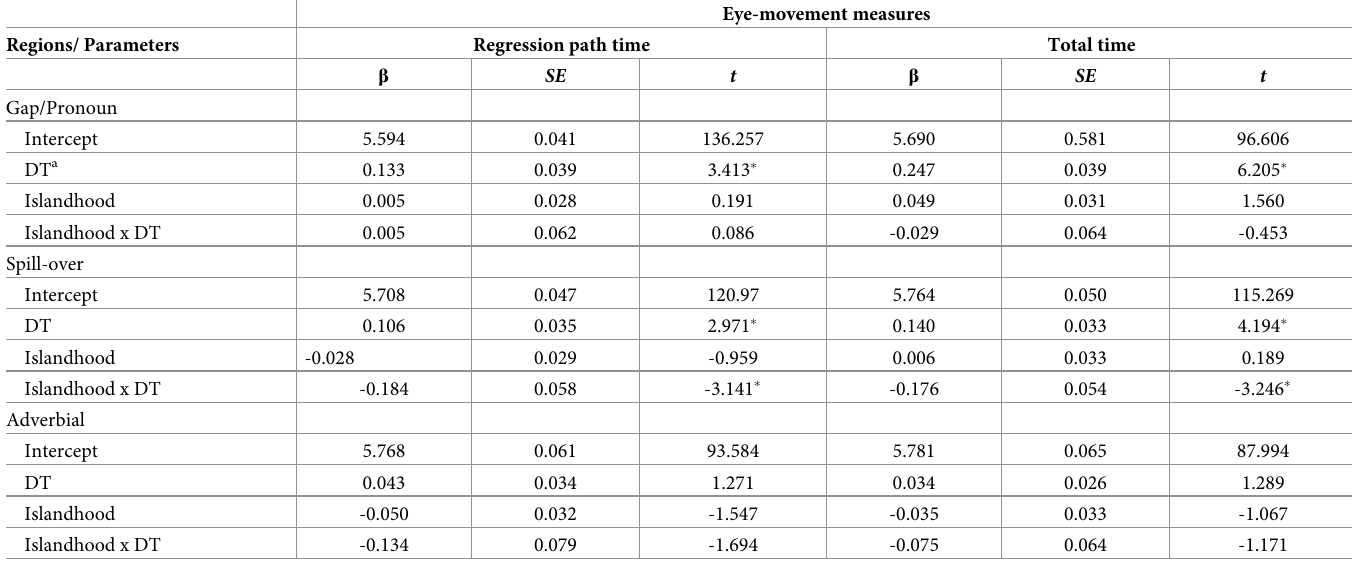
Table 5. Results of mixed-effects analysis for the eye-movement measures for Experiment